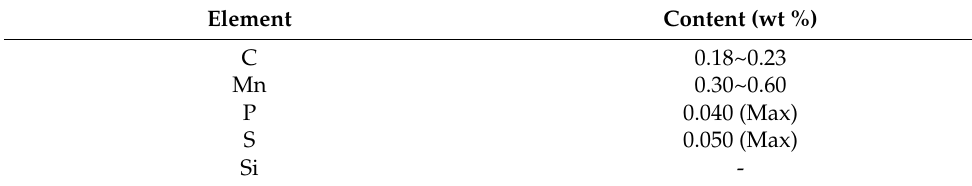
Table 7. Chemical composition of AISI 1020 steel by Wt.